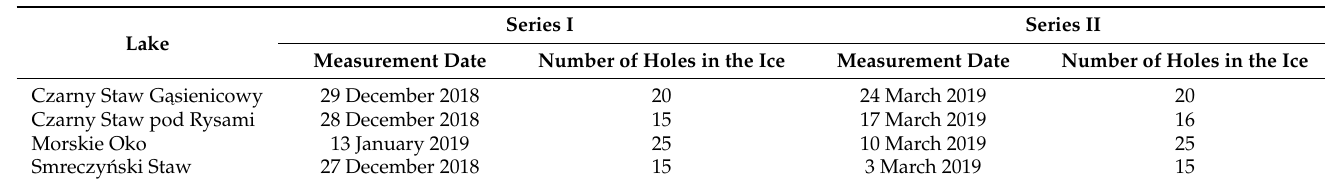
Table 2. Territorial and temporal scope of ice cover studies conducted in selected lakes in the Tatra Mountains during the 2018/2019 winter